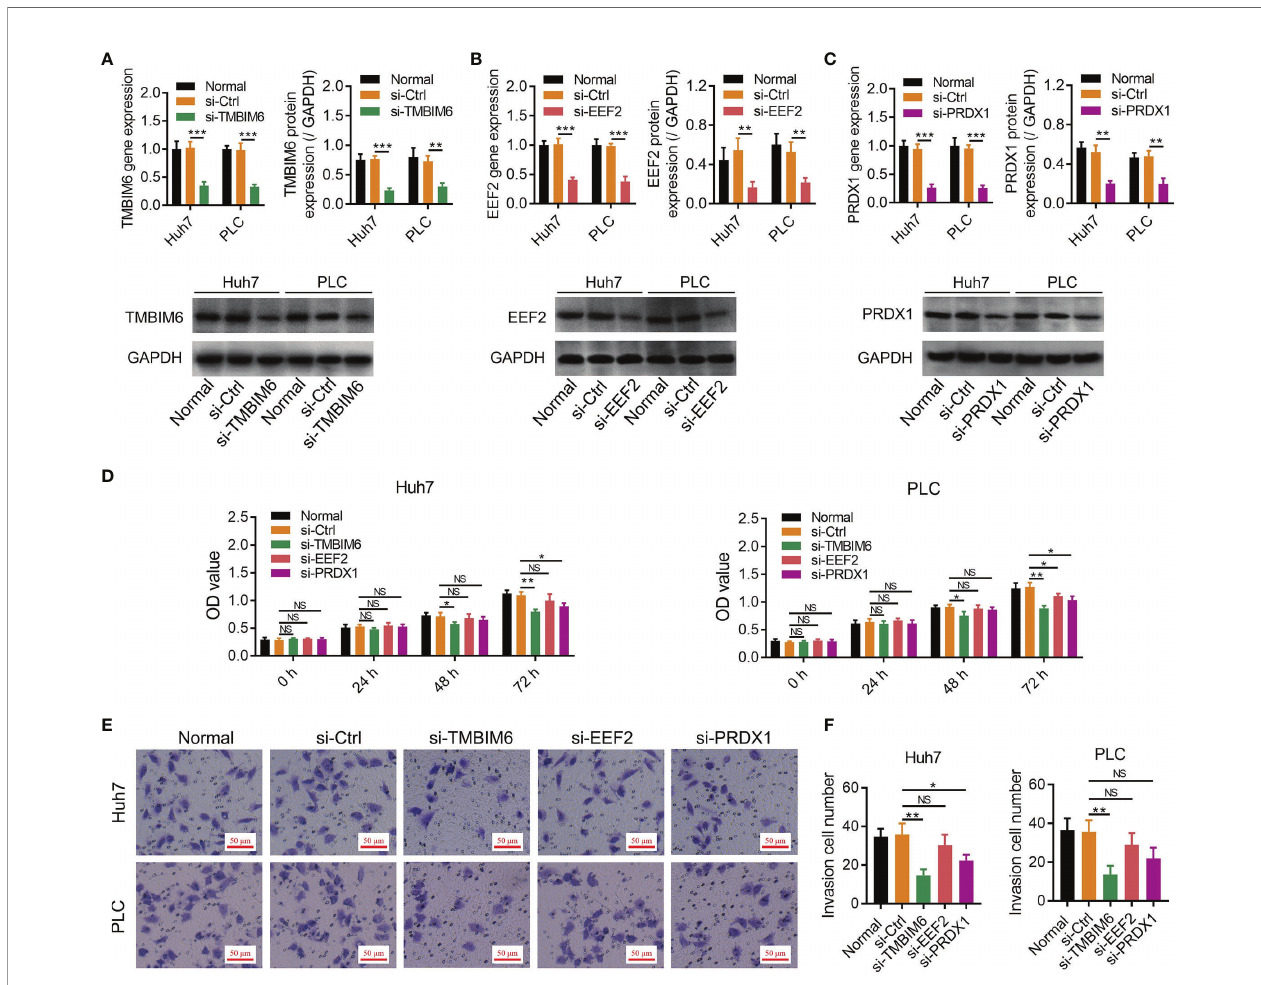
FIGURE 3 | Effect of TMBIM6, EEF2, and PRDX1 on viability and invasion of HCC cells. Expressions of TMBIM6 (A) , EEF2 (B) , and PRDX1 (C) in Huh7 and PLC cells after transfection. Comparison of viability (D) and invasion (E, F) among groups in Huh7 and PLC cells. HCC cells were cultured normally or transfected with control, TMBIM6, EEF2, or PRDX1 siRNAs. Purple cells indicate invaded cells in panel (E) NS, not signi fi cant; * p < 0.05; ** p < 0.01; *** p < 0.001. HCC, hepatocellular